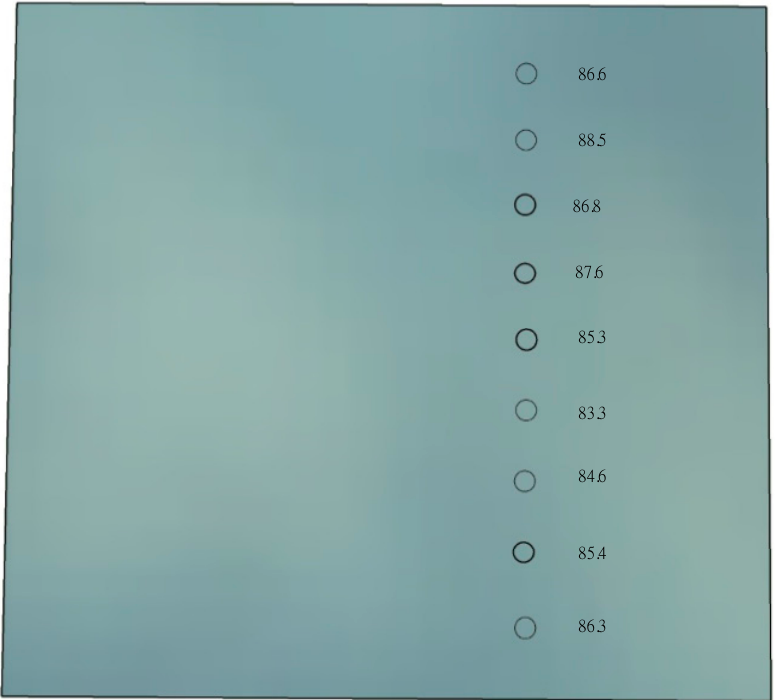
Figure 12. Automated measurement result of light transmittance after 3.5 days of dust deposition.